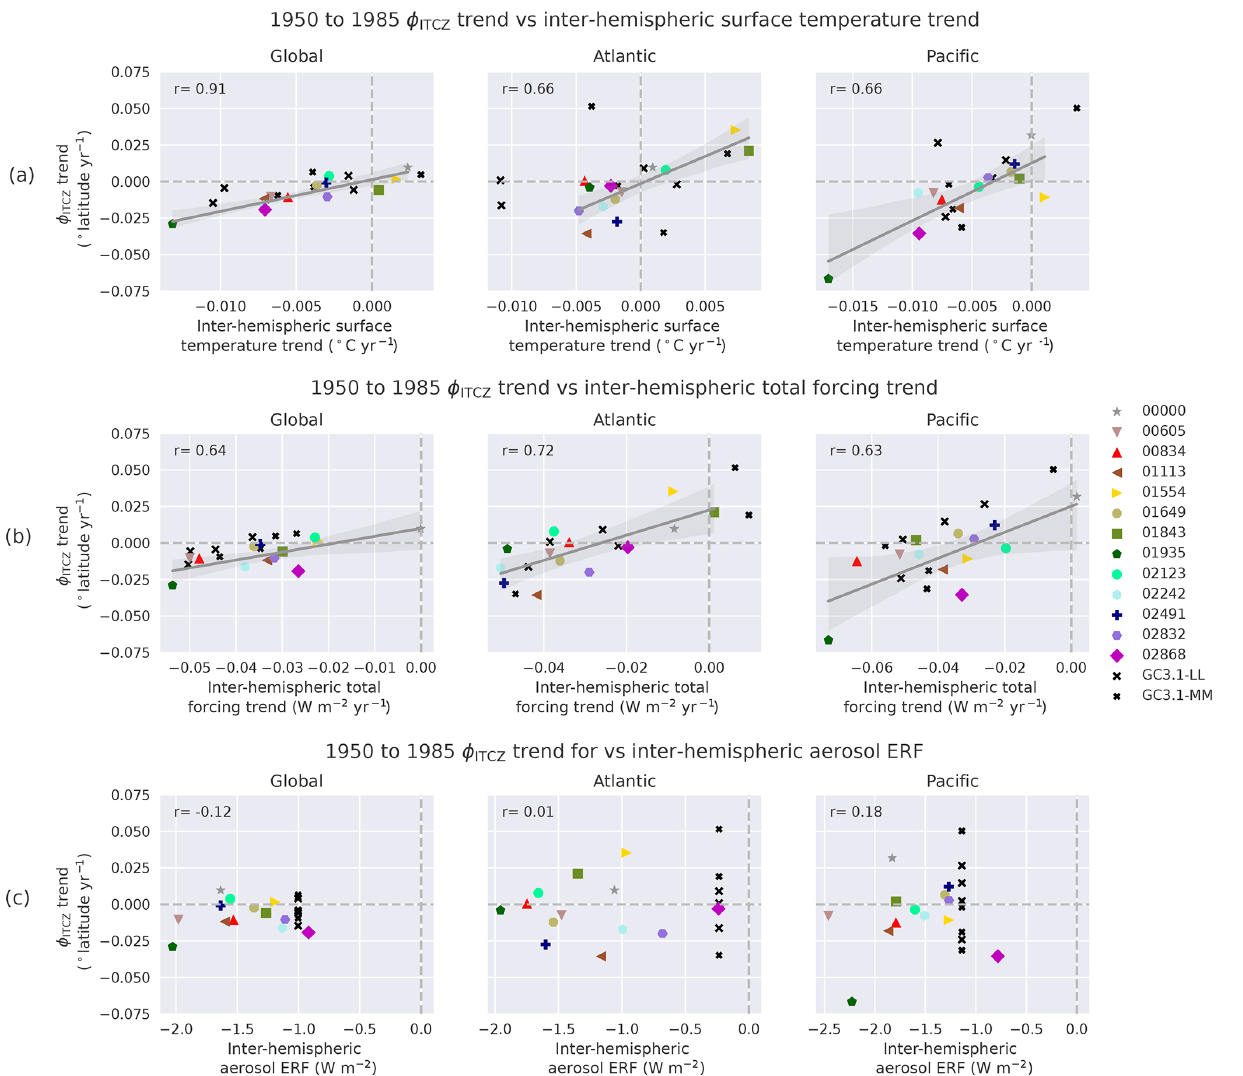
Figure 5. Scatter plot of the 1950 to 1985 trend in 5-year rolling mean (cid:56) ITCZ against the 1950 to 1985 trend in inter-hemispheric (over 60 ◦ S to 60 ◦ N) surface air temperature (a) , implied total radiative forcing (b) , and anthropogenic aerosol ERF (c) for global (left), Atlantic (middle), and Pacific (right) regional means. Anthropogenic aerosol ERF is calculated over 1860 to 1975 for the PPE and 1850 to 2014 for the initial condition ensemble. The Spearman rank correlation coefficient between variables is shown at the top left of each plot. Trend lines are shown in plots where r > 0 .